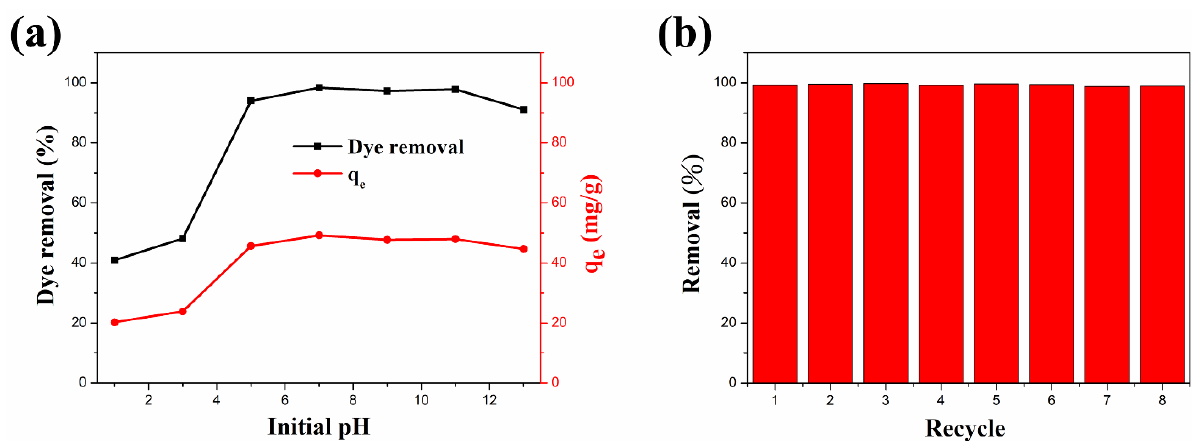
Figure 9. ( a ) Adsorption behavior of ZFG-18 affected by the dye solution initial pH. ( b ) Dye adsorption recycle test of ZFG-18. Conditions: adsorbent dosage = 10 mg, time = 30 min, MB concentration = 10 mg L − 1 , T = 295 K.